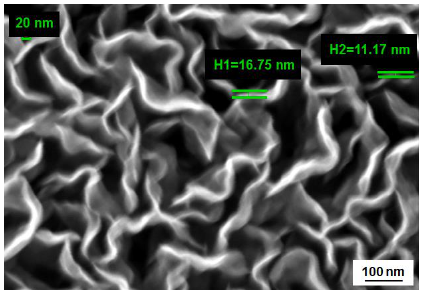
Figure A2. Representative FE-SEM image of VOG nanostructures, which were grown on the moving copper foil substrate by using a ICP CVD roll-to-roll method at the following technological parameters: deposition time: 5 min, partial pressure of propane: 2/5 in gas {C 3 H 8 + Ar} mixture and heating treatment: 40 min at 450 °C.